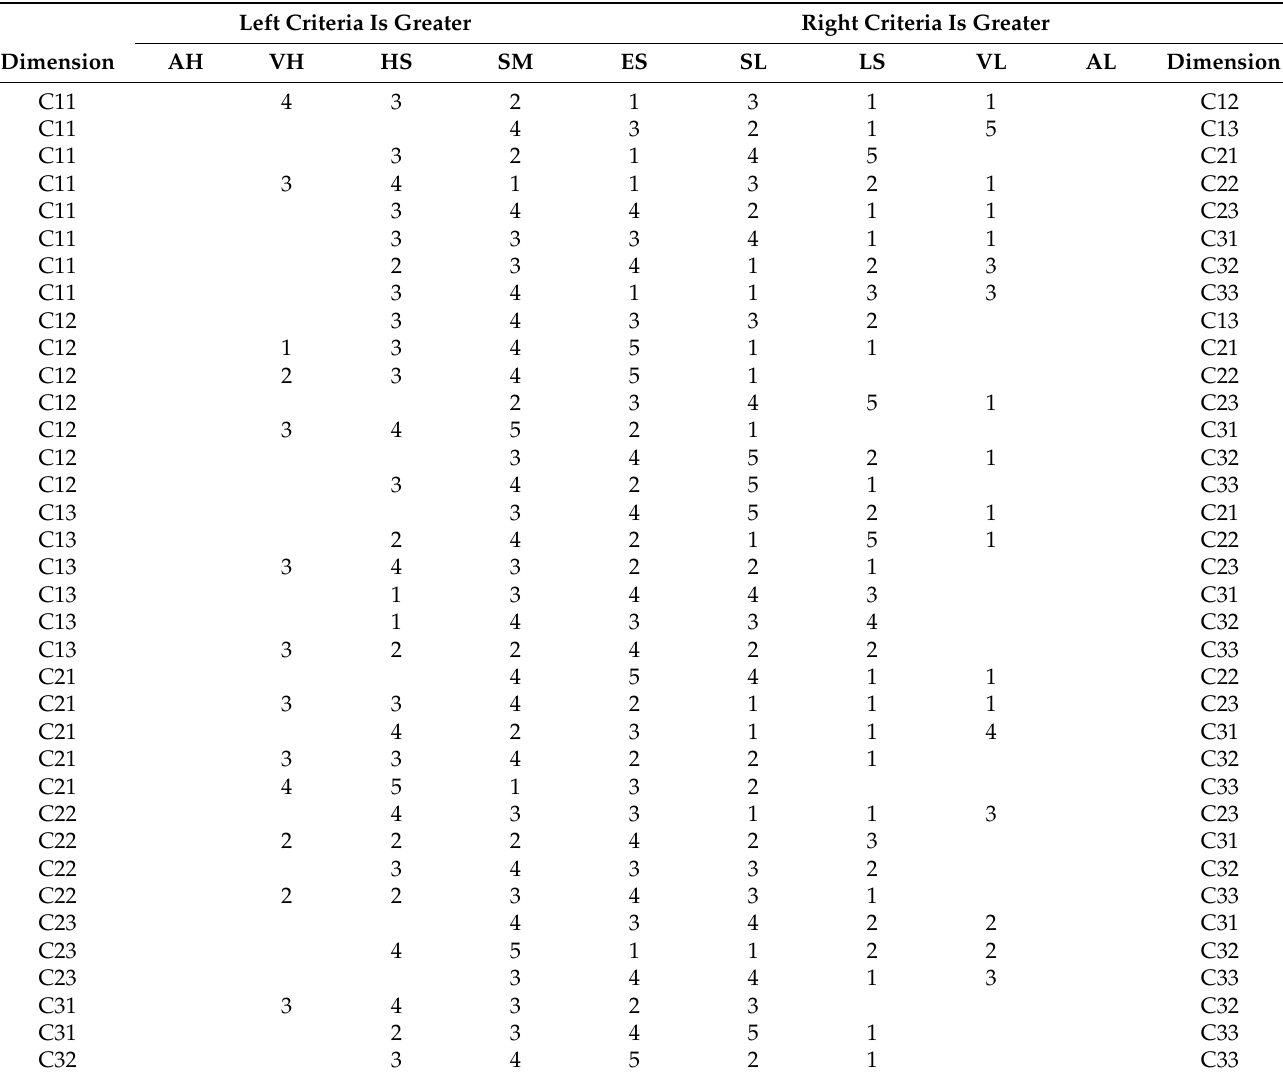
Table 3. Initial comparison matrices.